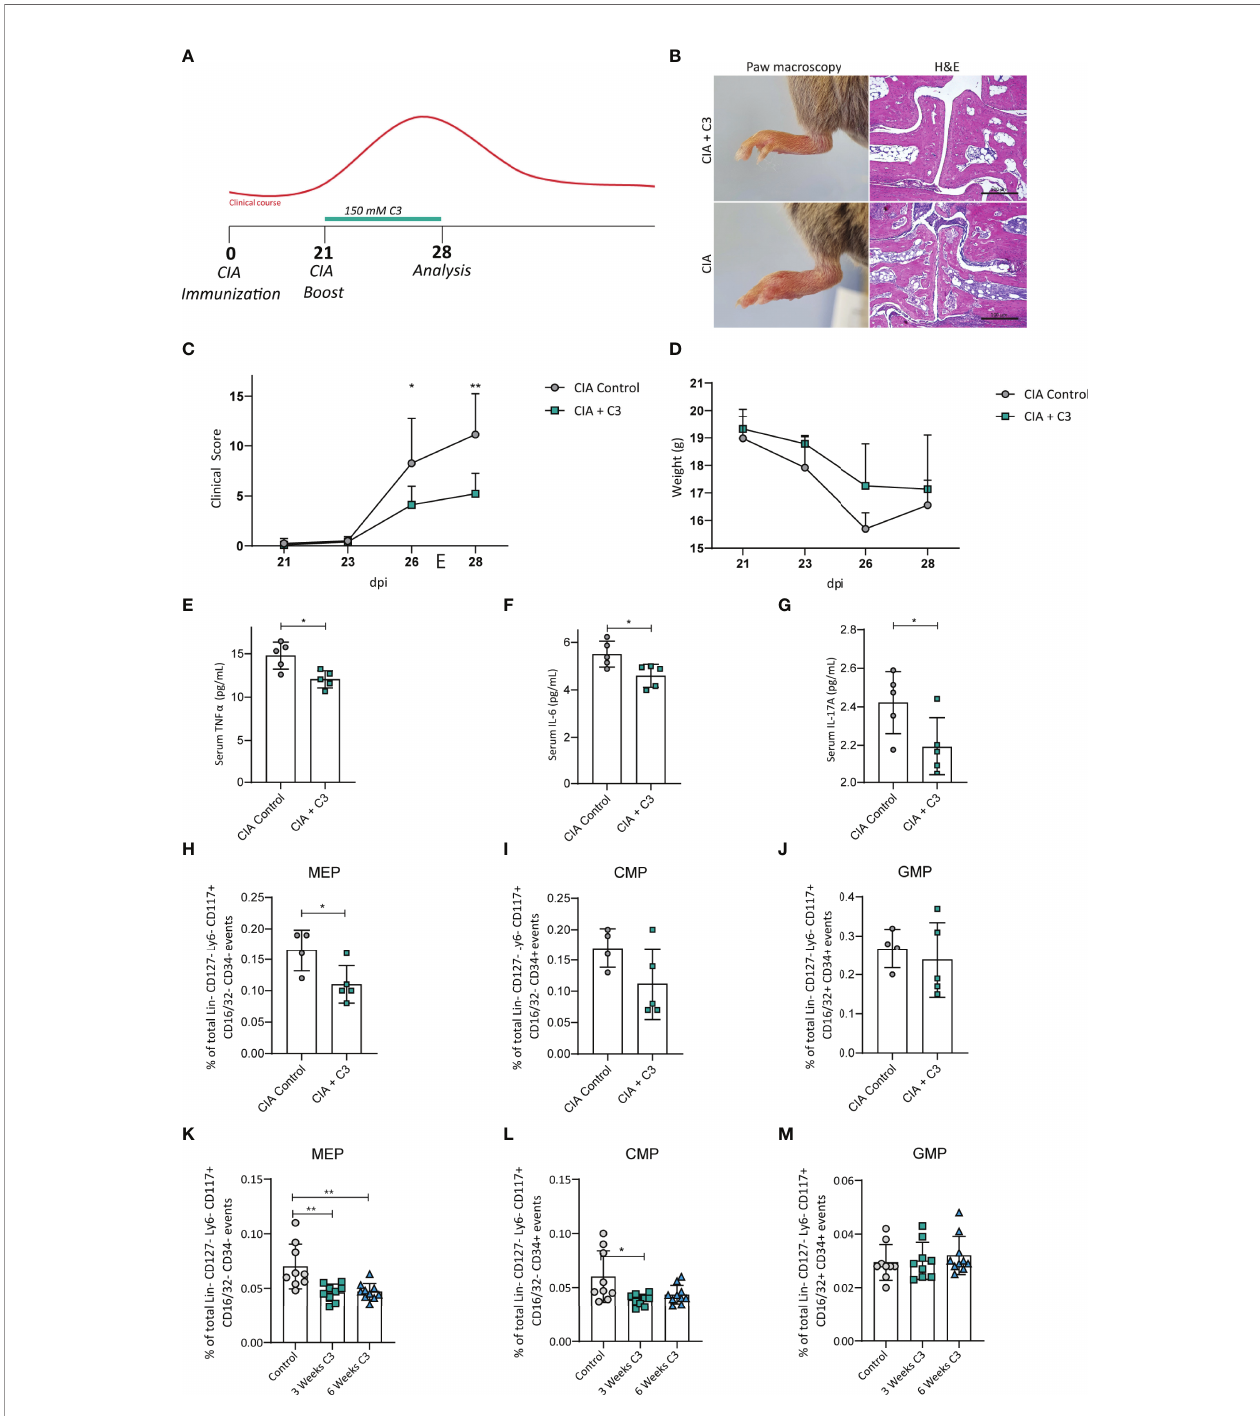
FIGURE 1 | C3 treatment induces changes of bone marrow progenitor cells in mice with CIA and naïve WT mice. (A) Flow diagram illustrating the experimental setup of C3 treatment (B) H&E staining of paw sections, (C) joint swelling clinical scores and (D) weight of CIA controls and CIA treated with 150 mM C3 in the drinking water. (E) Serum cytokine levels of TNF a (F) IL-6 and (G) IL-17A of CIA controls and CIA treated with 150 mM C3 in the drinking water. (H) Total percentage of bone marrow MEP, (I) CMP and (J) GMP of CIA controls and CIA treated with 150 mM C3 in the drinking water. (K) Total percentage of MEP, (L) CMP and (M) GMP in untreated naïve controls and naïve mice treated with 150 mM C3 in the drinking water for 3 and 6 weeks. Pictures are representative for 2 independent experiments. Data are expressed as the mean ± sd. Statistical difference was determined by Two-way ANOVA, Student ’ s t-test and One-way ANOVA. *p < 0.05; **p <